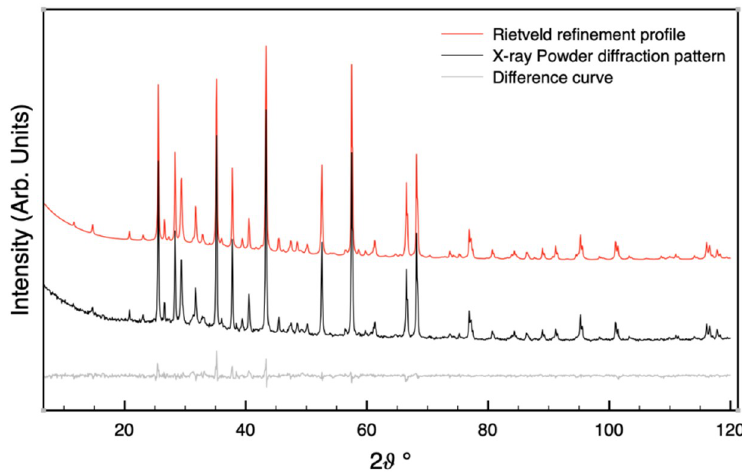
Figure 2. XRD pattern and corresponding Rietveld refined profile made on stabilized sample A, one month after the sample synthesis. Difference curve is also plotted.